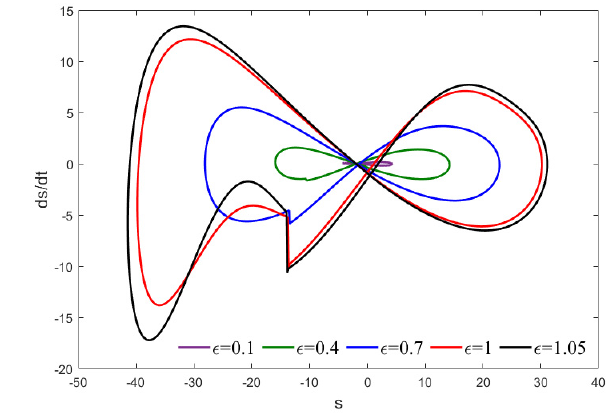
ε . Figure 14. The phase portraits of s −